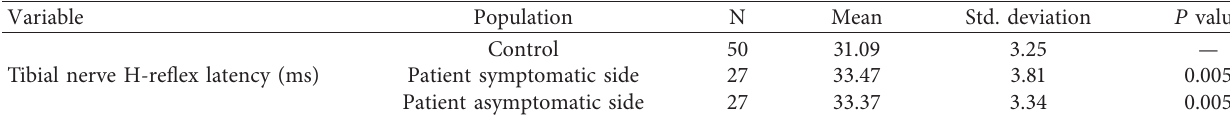
Table 6: H-reflex latency (control vs symptomatic side and control vs asymptomatic side).